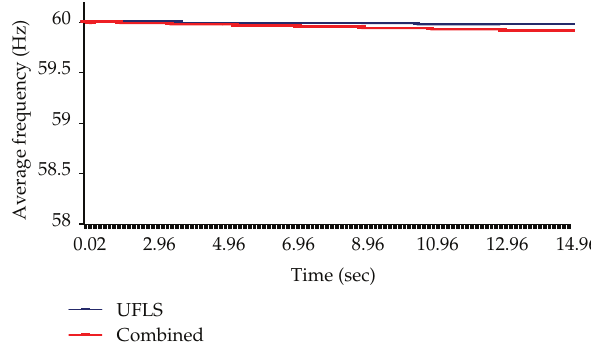
Figure 11: Average frequency responses when both schemes are applied.